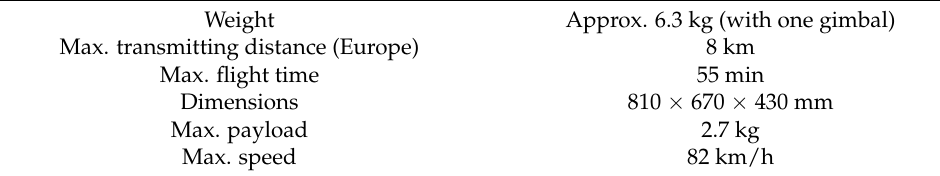
Table A2. Basic characteristics of UAV DJI Matrice 300.